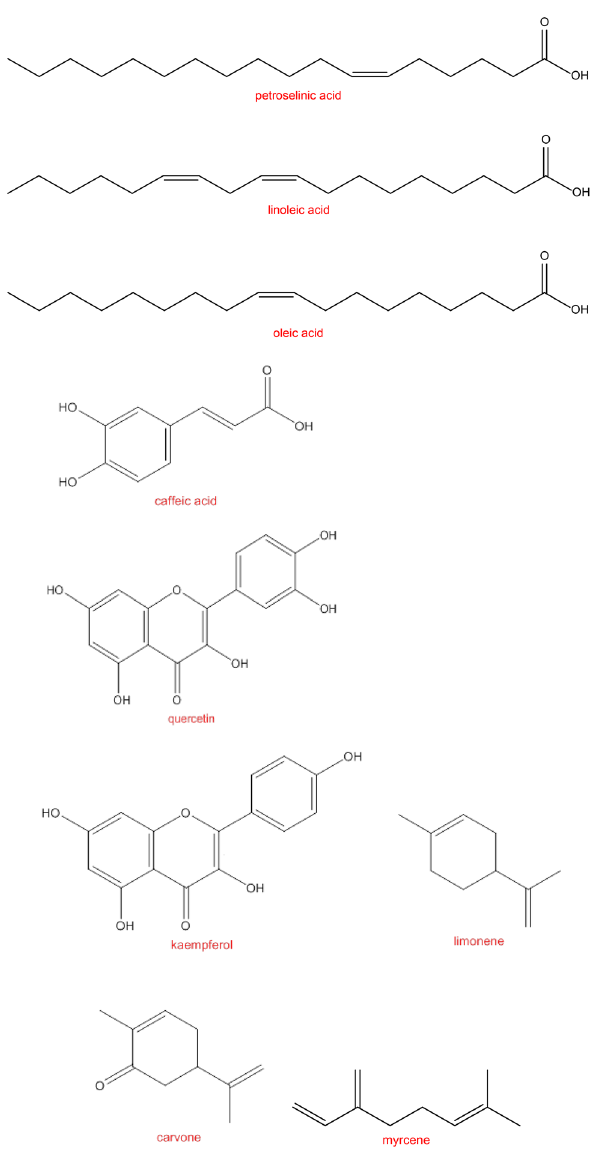
Fig. 1 The chemical structure of main components of caraway